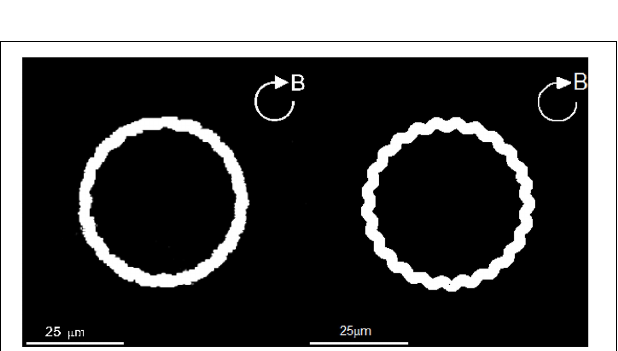
FIGURE 6 | The swimming trajectories of a rod-shaped magnetotactic bacterium under the influence of an externally imposed rotating magnetic field (Equation 39) with B 0 = 14 . 00 × 10 − 4 T and (cid:2) 0 = 2 . 5133/s. The left panel is recorded in our laboratory experiment with a charge-coupled device camera while the right panel shows a numerical solution of the twelve coupled equations using the parameters listed in Table 2 .